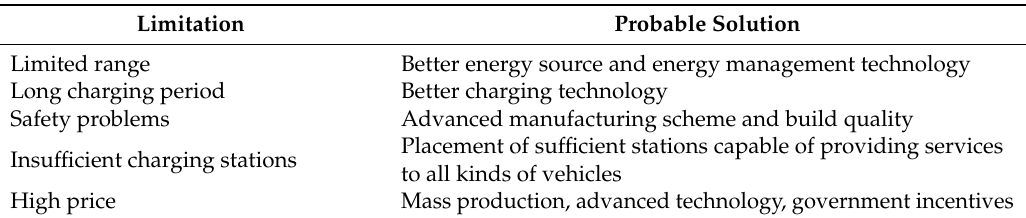
Table 29. Tentative solutions of current limitations of EVs.